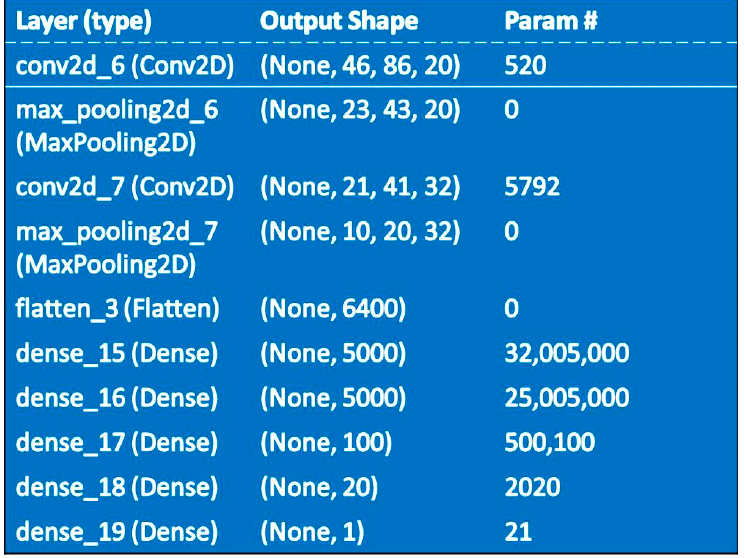
Figure 13. The structure of the CNN model. The model is composed of two consecutive convolutional and max_pooling layers for feature extraction; the output shapes are presented. A flattened layer was used to convert the resulting feature maps in one-dimensional array via the flattening. All were activated by a rectified linear-unit function. The ANN section of the model has four deep layers, containing 5000, 5000, 100, and 20 neurons activated by a rectified linear-unit function, leading to a single output